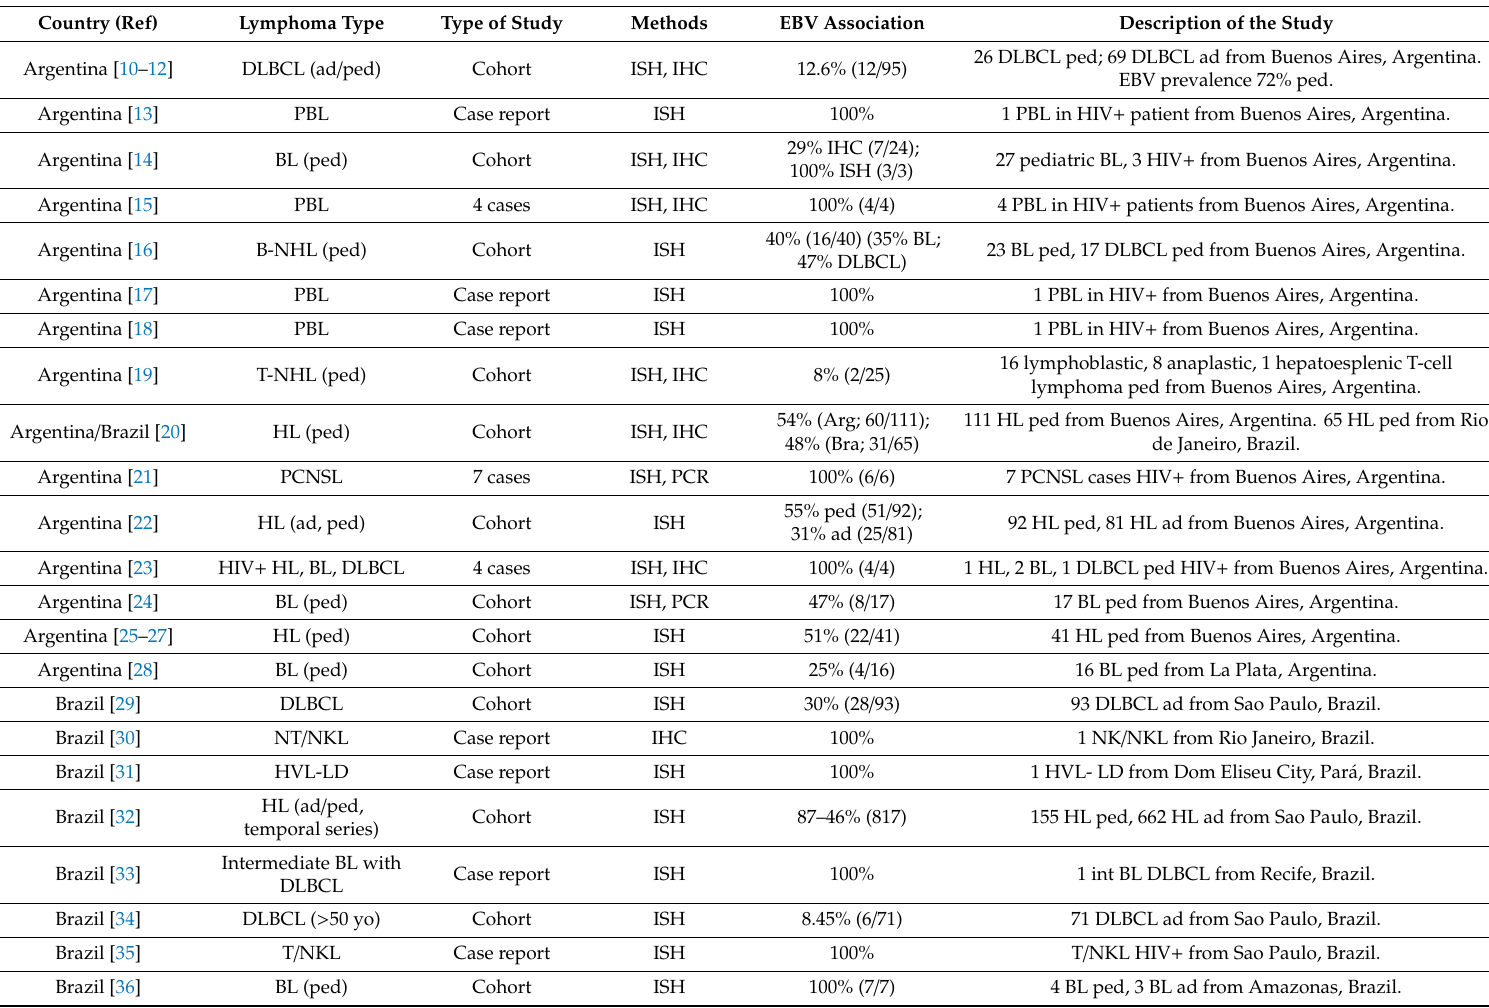
Table 1. Summary of studies about Epstein–Barr virus (EBV) associated